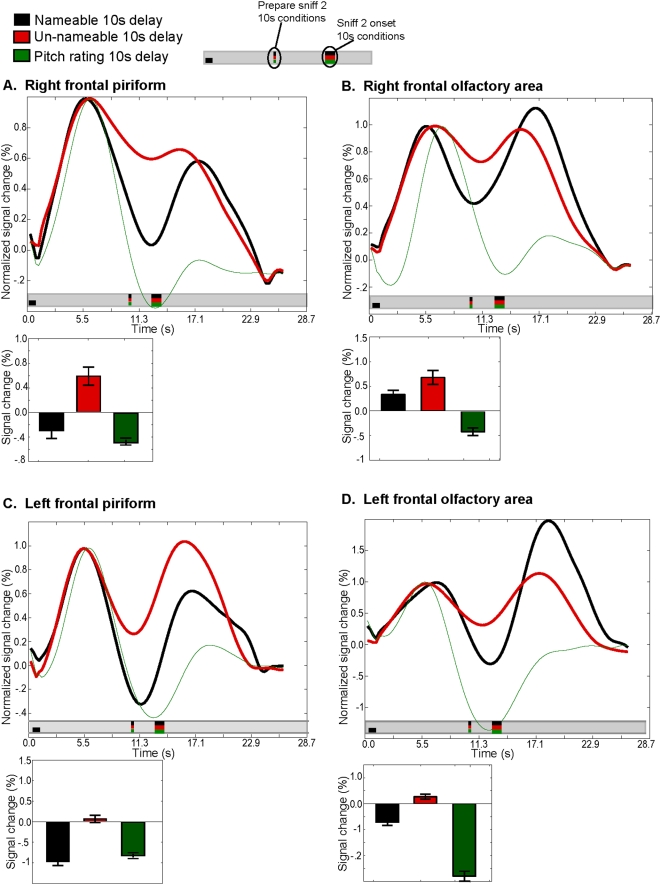
Memory-related activity in piriform cortex.Each panel shows the time course of activity that has been normalized such that the maximum response to sniff-one is equal to 1. This enabled comparisons of activity levels during the delay period. Only the nameable (in black) and unnameable (in red) 10-second-delay conditions are shown along with an additional control condition in which subjects remembered auditory pitches (in green) for 10 seconds. Bar graphs depict the minimum activity level from 6-seconds after the first sniff to the time that the subject was instructed to prepare for the second sniff. This provides a measure of how well activity levels were sustained during the delay (note that because the bar graphs in this figure depict the minimal value, the bar may reveal a negative value even when the mean was positive, e.g., black line in panel A). A. Memory-related activity in right frontal piriform cortex. B. Memory-related activity in right frontal olfactory area. C. Memory-related activity in left frontal piriform cortex. D. Memory-related activity in left frontal olfactory area. In all subregions, the level of activity during the delay period was greater when subjects were remembering unnameable odorants as compared to nameable odorants. In the olfactory area, activity levels were hierarchically organized in the following manner: unnameable>nameable>auditory pitch. In frontal piriform cortex, remembering unnameable odors elicited more activity than nameable odors, but remembering nameable odors and auditory pitches both elicited a similar level of activity during the delay (unnameable>nameable = auditory pitch).